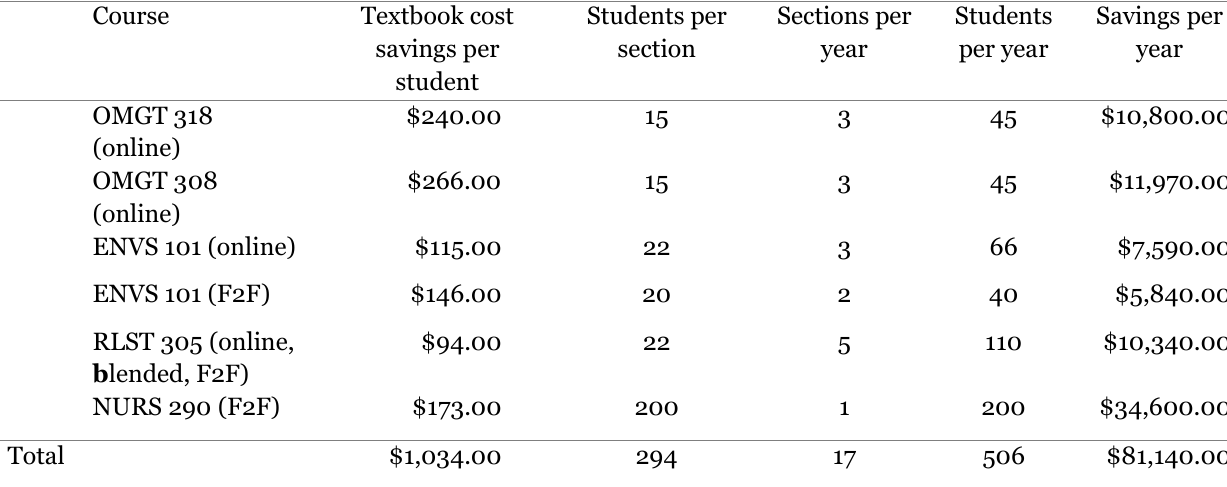
Cost Savings by